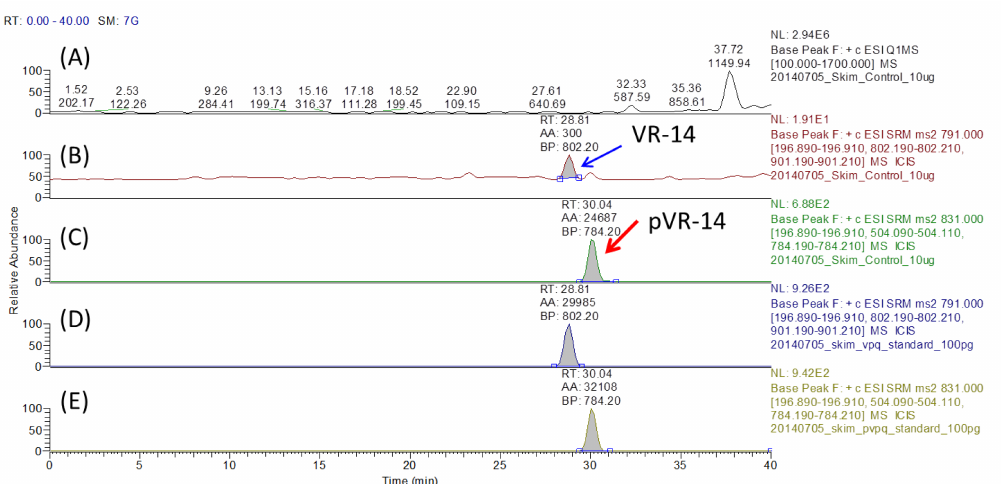
Figure 4. Absolute quantification (AQUA) validation of the phosphorylation degree at Ser130 of α -S1-casein with LC-MS / MS (SRM in TSQ) analysis. ( A ) The full LC-MS chromatogram for the whole tryptic digest of skim milk proteins; ( B ) the SRM chromatogram of VR-14 in tryptic skim milk digest; ( C ) the SRM chromatogram of pVR-14 in tryptic skim milk digest; ( D ) the SRM chromatogram of